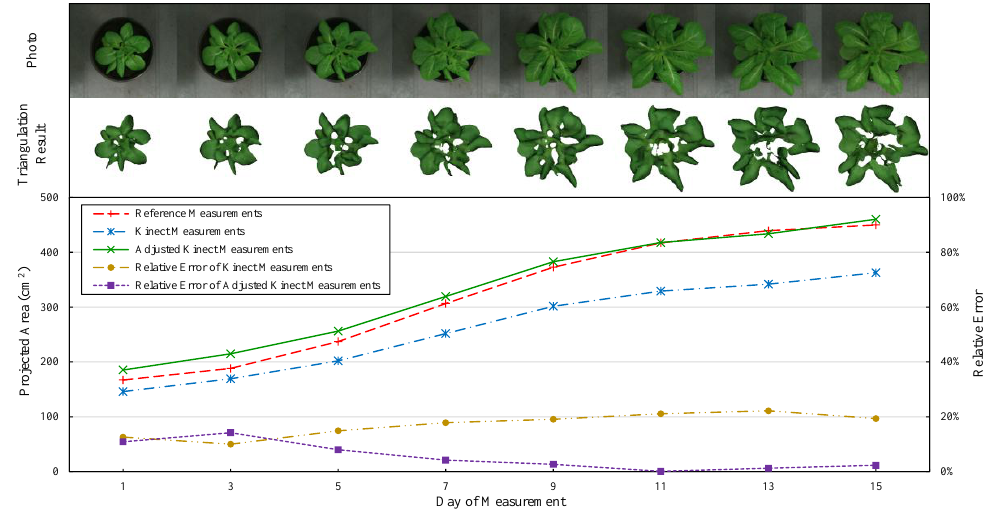
Figure 13. Results of projected leaf area monitoring (periodical measurement) for a single plant.